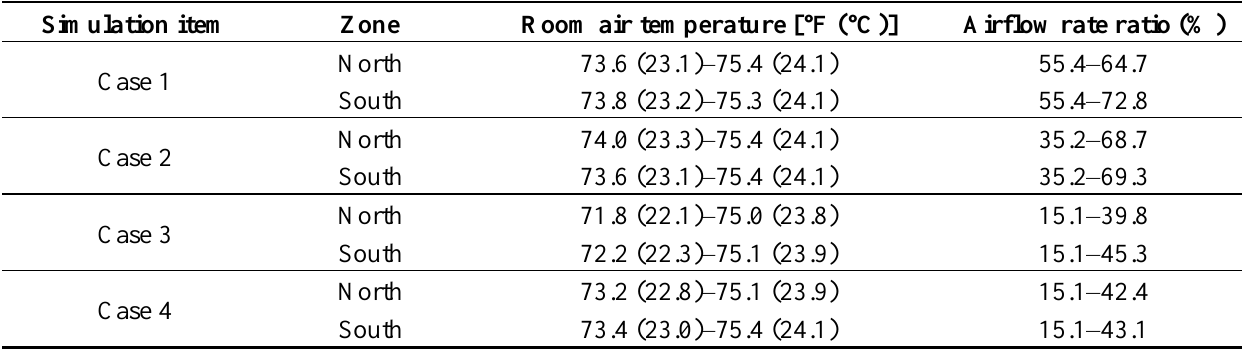
Table 3. Simulation data of room air temperature and airflow rate